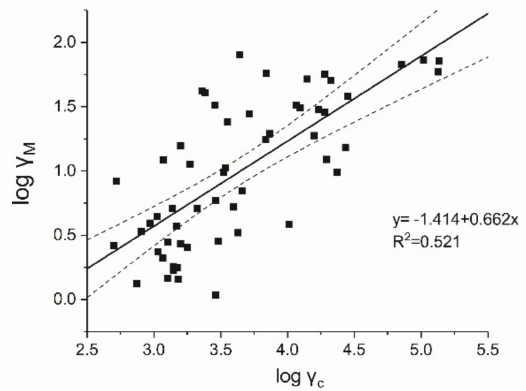
Figure 5. Correlation between mic gene copies and 2-MIB concentrations in Yanlonghu CW-R. γ c ( x -axis) and γ M ( y -axis) correspond to the mic abundance (copies/mL) and 2-MIB concentration (ng/L), respectively, with the 95% confidence interval (broken line).